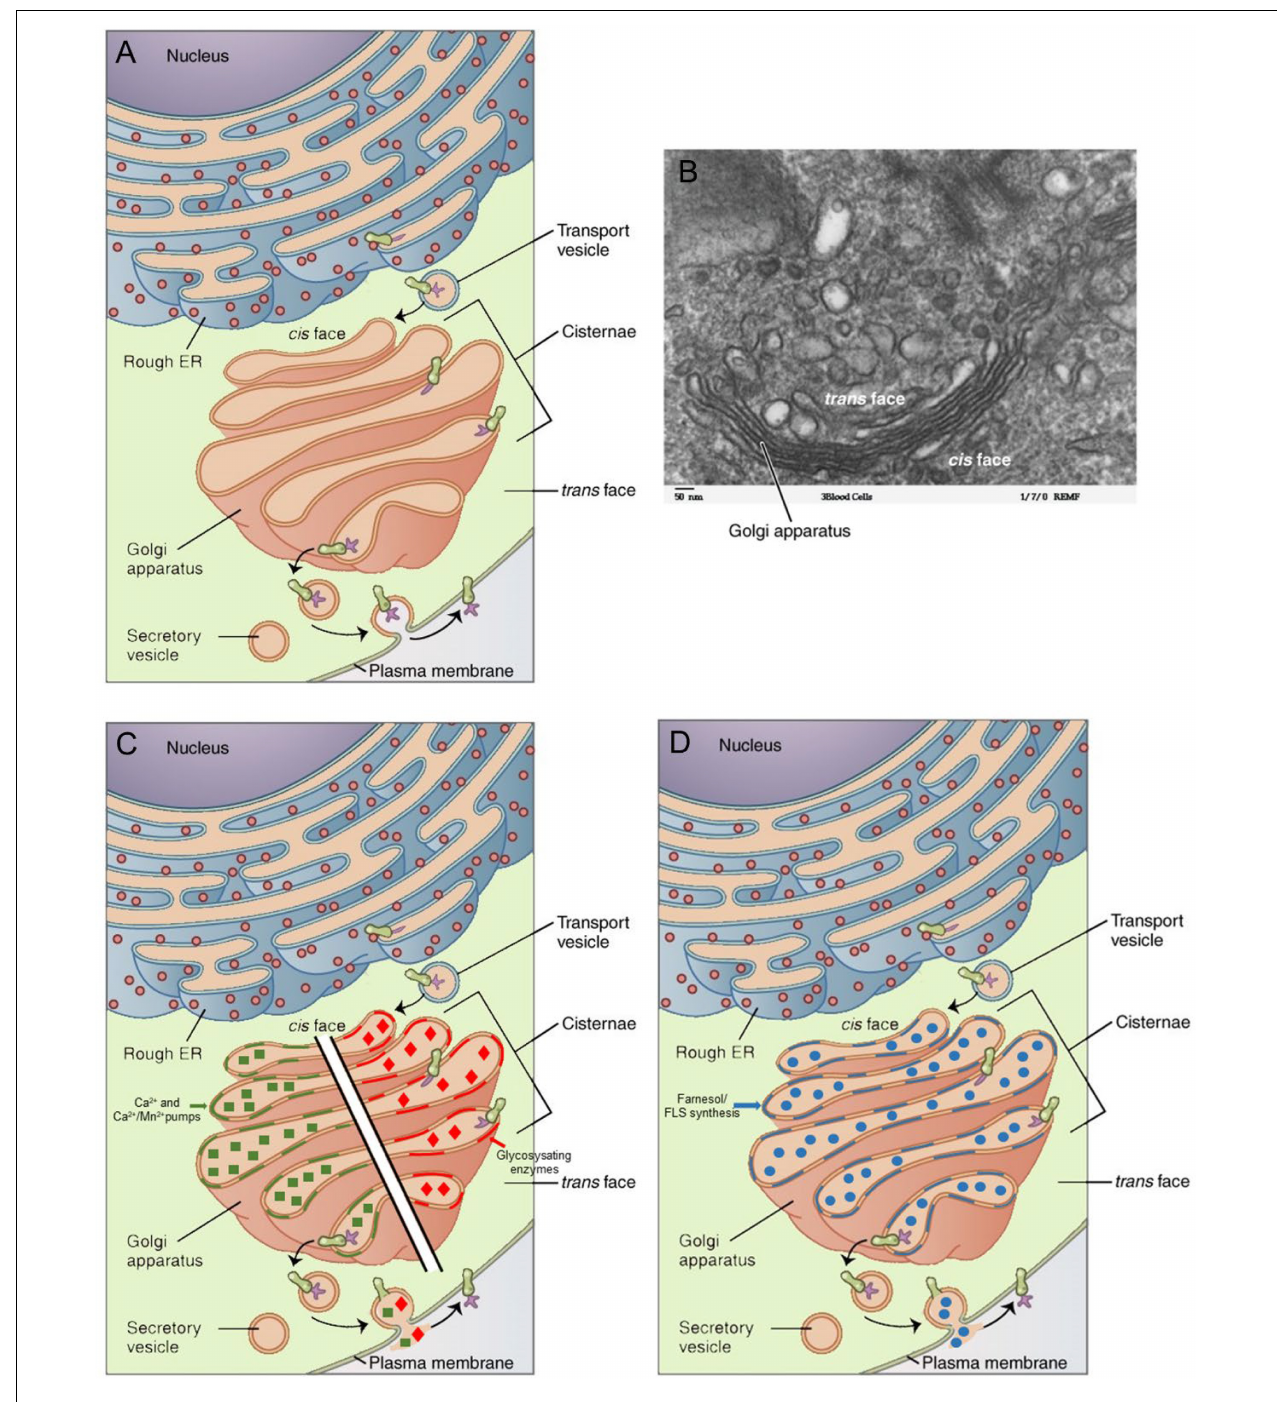
FIGURE 3 | Golgi apparatus in context of the secretory pathway: (A) Schematic representation (Golgi in salmon pink). (B) Electron micrograph. (C) Schematic representation of the Ca 2 + - and the Ca 2 + /Mn 2 + pumps as well as of glycosylating enzymes in the membranes. (D) The Golgi membranes also contain enzymes for the synthesis of farnesol/farnesol-like sesquiterpenoid (FLS). The major function of the rough endoplasmic reticulum (RER)–Golgi apparatus is the removal of excess Ca 2 + from the cytoplasm, an activity that requires the synthesis of cell type-specific transport proteins in the RER. From here, proteins are sent to the Golgi apparatus, which organizes, modifies (e.g., by glycosylation), packages, and tags them. Some of these products are transported to other areas of the cell, and some are exported from the cell through exocytosis. Enzymatic proteins are packaged as new lysosomes (or packaged and sent for fusion with existing lysosomes) (Nakano and Luini, 2010). A reanalysis of classical data from insect endocrinology (see text) revealed that the Golgi apparatus is the likely site of synthesis of farnesol and farnesol-like sesquiterpenoids (FLSs), the juvenile hormones of insects being the best known ones. Copyright permission: (A–D) All under Creative Commons license CC BY 4.0. (A,B) Original files unchanged from Wikipedia File 0314 Golgi Apparatus.jpg (Created May 18, 2016). (C,D) Slightly modified from this file.